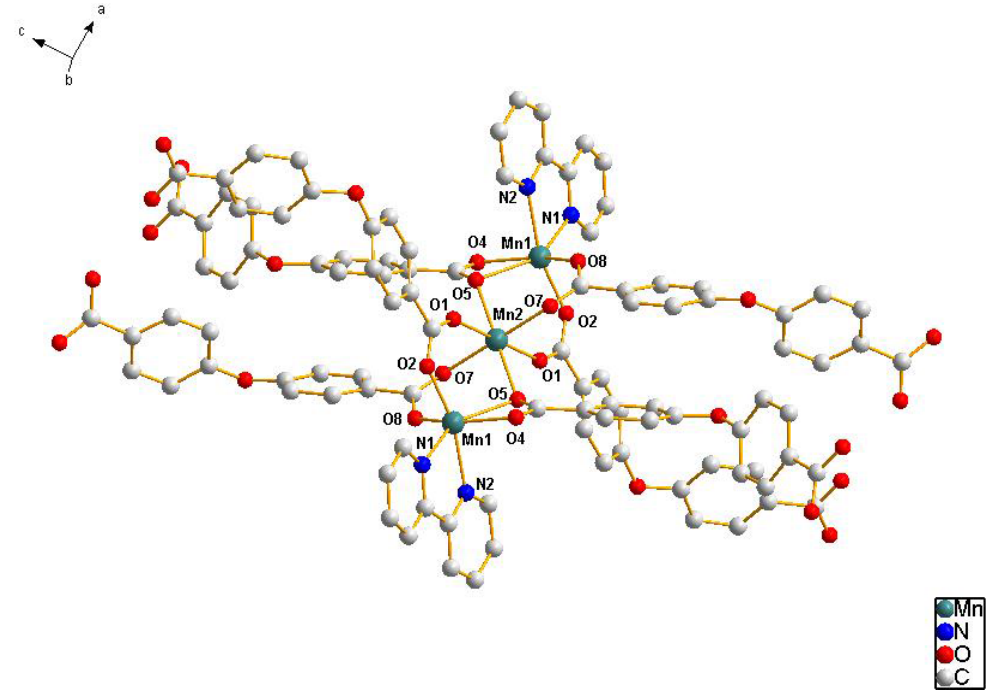
Figure 1. The coordination environment of 1 . All H atoms are omitted for